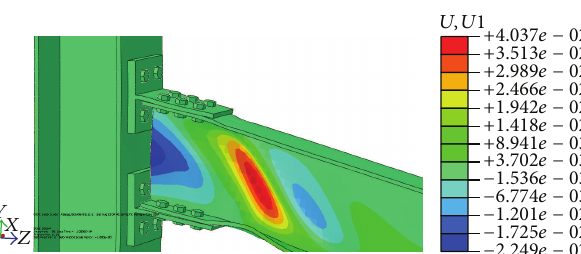
Figure 15: Shift diagram in the middle of the beam for connection to the bolted T joint.